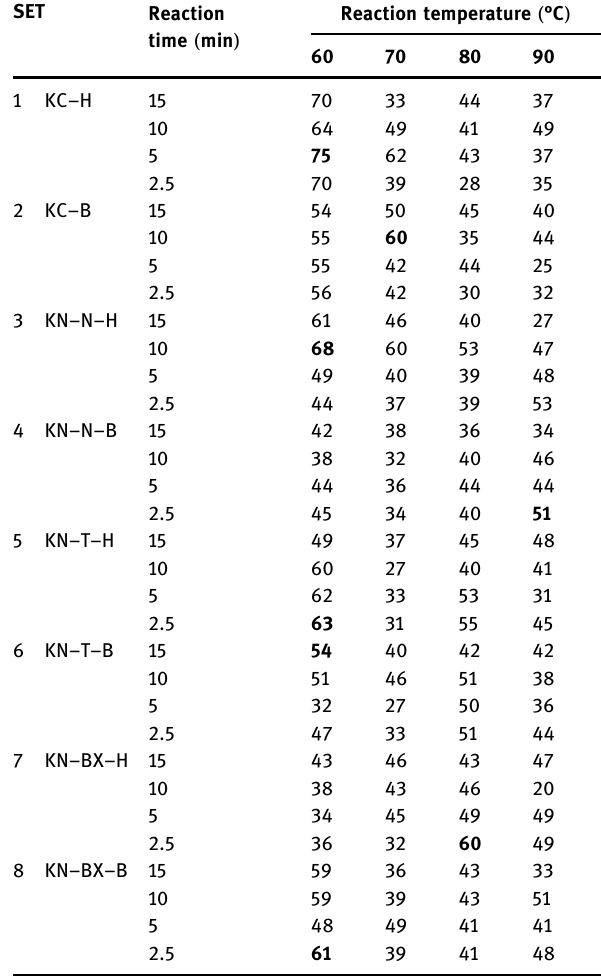
Table 1: XRD scores of the synthesized santite minerals